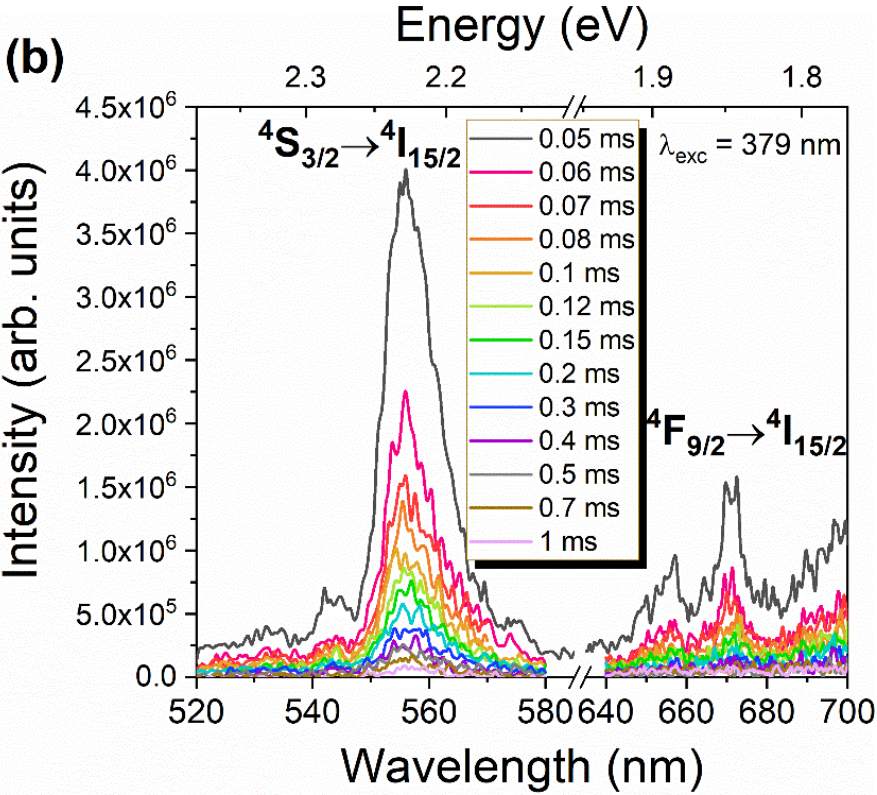
Figure 10. TRPL spectra obtained for the HT1200 sample under two excitations: ( a ) 300 nm; ( b ) 379 nm.